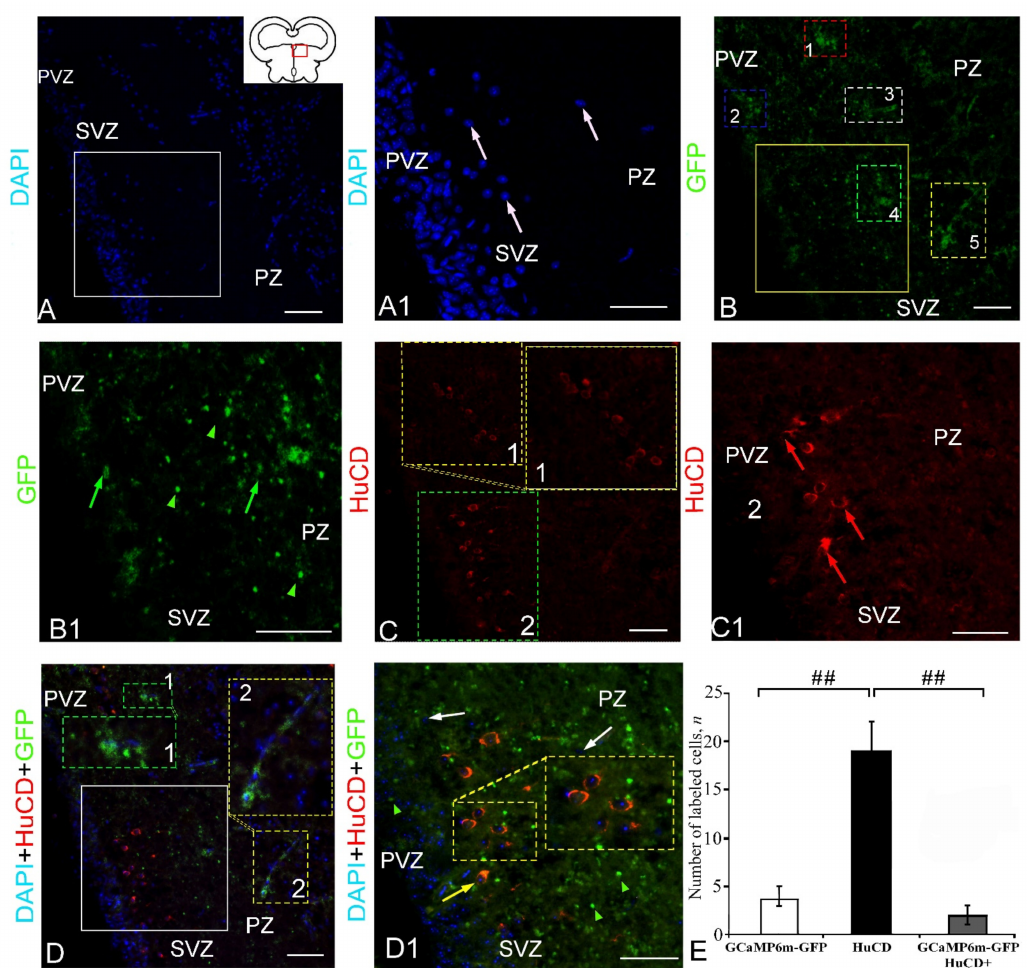
Figure 8. Z-stacks showing DAPI staining, localization of green fluorescent protein GFP and HuCD, and their co-localization in the epithalamus of juvenile chum salmon, O. keta , at 90 days after a single injection of the rAAV into the cerebellar body. ( A ) DAPI staining with a pictogram showing an area of epithalamus (in a red box); white box outlines the subventricular aggregation of DAPI-stained nuclei; PVZ, periventricular zone; SVZ, subventricular zone; PV, periventricular zone. ( A1 ) The enlarged fragment outlined by a white box in A; heteromorphic DAPI-stained nuclei with nucleoli (white arrows). ( B ) GFP expression in populations of epithalamic neurons (1–5). ( B1 ) The enlarged fragment outlined by a yellow box in B; GFP+ neurons (green arrows) and GFP+ granules (green arrowheads). ( C ) Immunofluorescence of the HuCD protein in populations of epithalamic neurons; the yellow dotted inset is an enlarged fragment of population 1. ( C1 ) An enlarged fragment of population 2 (green box in C); HuCD+ neurons (red arrows). ( D ) Optical overlay of three DAPI/GFP/HuCD staining channels showing areas of GFP/HuCD co-localization in neurons (yellow dotted box). ( D1 ) The enlarged fragment outlined by a yellow dotted box in D; neurons co-expressing GFP and HuCD (yellow arrows), DAPI-stained nuclei (white arrows), GFP+ neurons (green arrows), GFP+ granules (green arrowheads), population 1 co-localization areas (green inset), and population 2 (yellow inset). ( D1 ) The enlarged fragment outlined by a white box in D, showing DAPI/GFP/HuCD co-localization in neurons (dashed yellow inset); single cell with colocalization (yellow arrow), DAPI- stained nuclei (white arrows), and GFP+ granules (green arrowheads). Laser scanning confocal microscopy. Scale bar: ( A , B , C , D ) 100 µ m; ( A1 , B1 , C1 , D1 ) 50 µ m. ( E ) Results of the one-way ANOVA showing the comparative distribution of GFP and HuCD immunolabeled cells (M ± SD) in the epithalamus of juvenile chum salmon, O. keta . Significant intergroup differences were found in the GCaMP6m-GFP and HuCD groups, and also in HuCD and GCaMP6m-GFP/HuCD (## <0.01) ( n = 5 in each